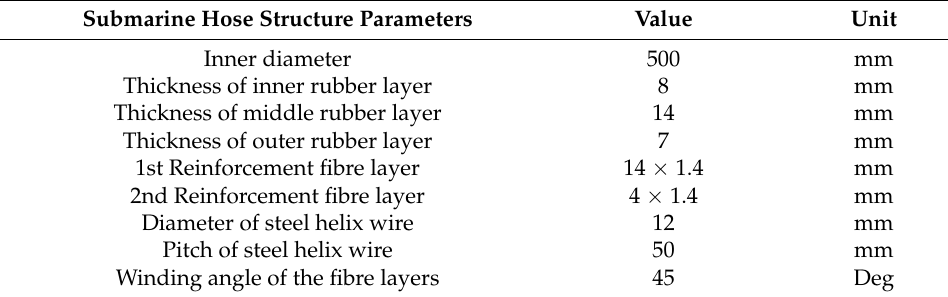
Table 1. Main structural parameters of submarine hose.